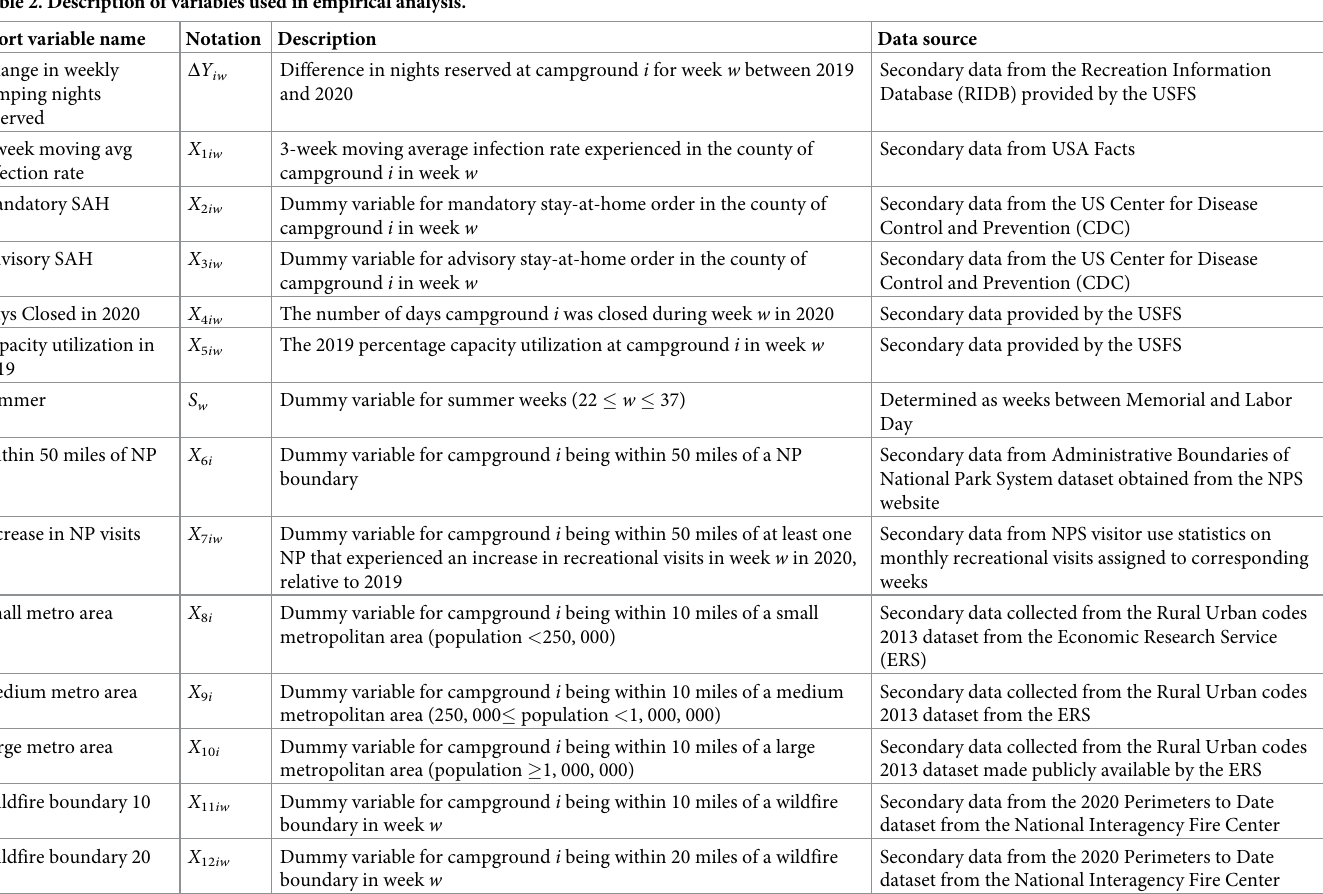
Table 2. Description of variables used in empirical